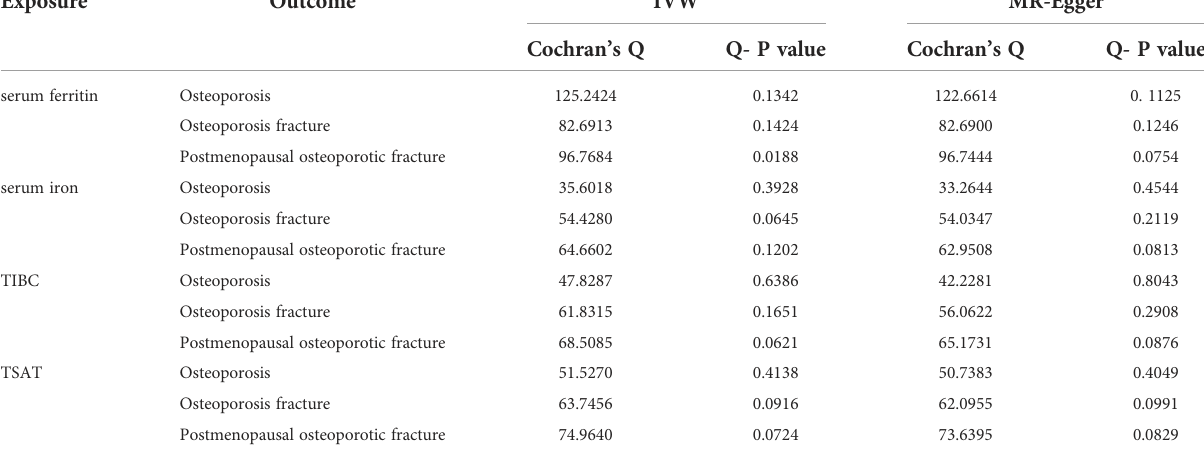
TABLE 3 Heterogeneity